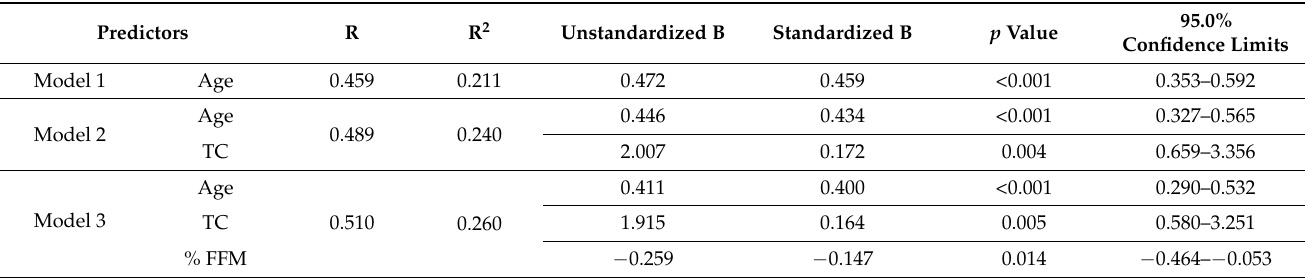
Table 3. Stepwise linear regression analysis to determine the significant predictors of high-risk lipoprotein(a)